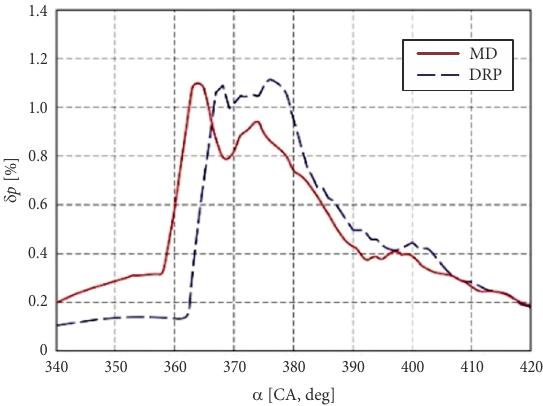
Figure 6. Mean cycle-by-cycle differences in cylinder pressure vs CA for MD and DRP (3000 rpm / 200 N ⋅